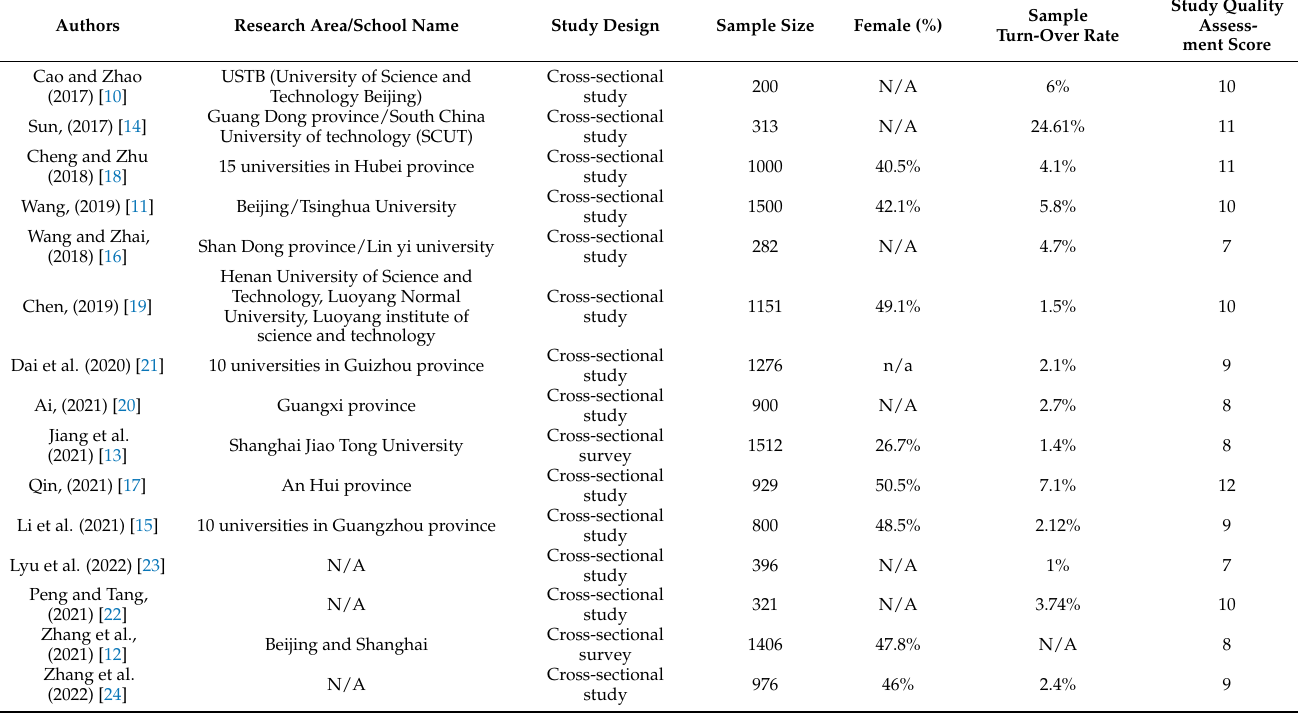
Table 1. Basic information of included